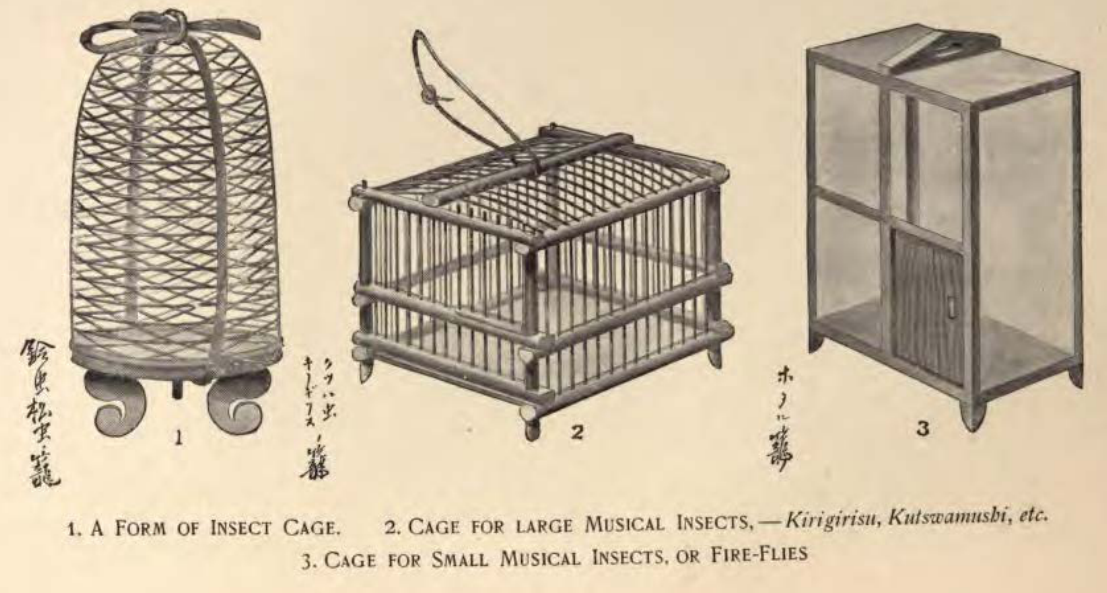
Figure 9. Insect cages. Hearn, L. Exotics and Retrospectives . Little, Brown, and Co.: Boston, MA, USA, 1898, pp. 50–51. [70].